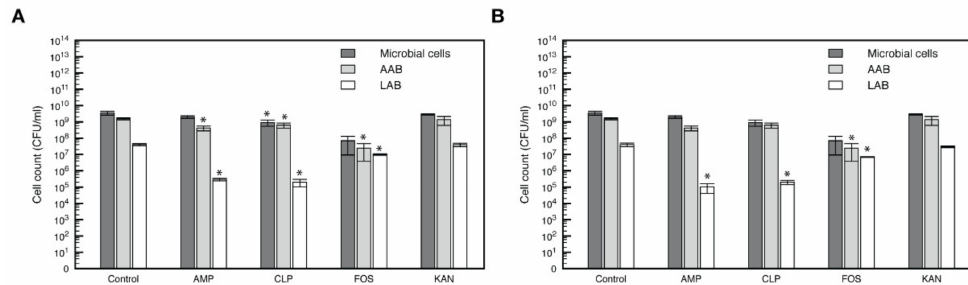
Figure 3. Bacterial susceptibility to antibiotics in kefir beverages. Count of total microbial cell, acetic acid bacteria (AAB) and lactic acid bacteria (LAB) in kefir beverages K02 ( A ) and K03 ( B ) supplemented with ampicillin (AMP) at 100 µ g/mL, chloramphenicol (CLP) at 50 µ g/mL, fosfomycin (FOS) at 50 µ g/mL, and kanamycin (KAN) at 50 µ g/mL. Kefir beverages produced in absence of antibiotics were used as controls. All microbial counts were evaluated in triplicates and error bars correspond to standard deviations. Asterisks denote statistically significant changes ( p <